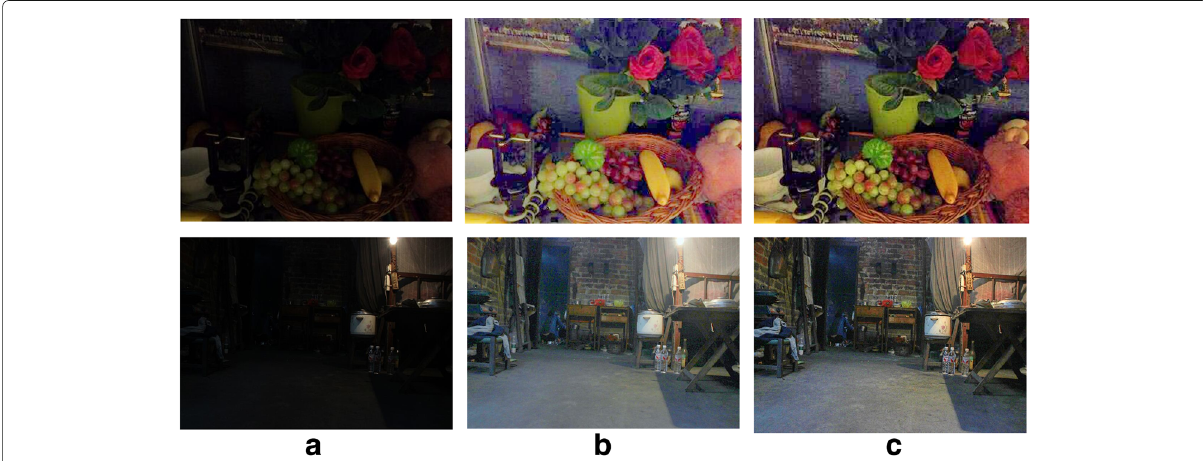
Fig. 12 Comparison of the proposed method with multi-scale retinex with color restoration (MSRCR) [13]. a Input images. b Enhanced images with multi-scale retinex with color restoration (MSRCR) [13]. c Enhanced image with the proposed